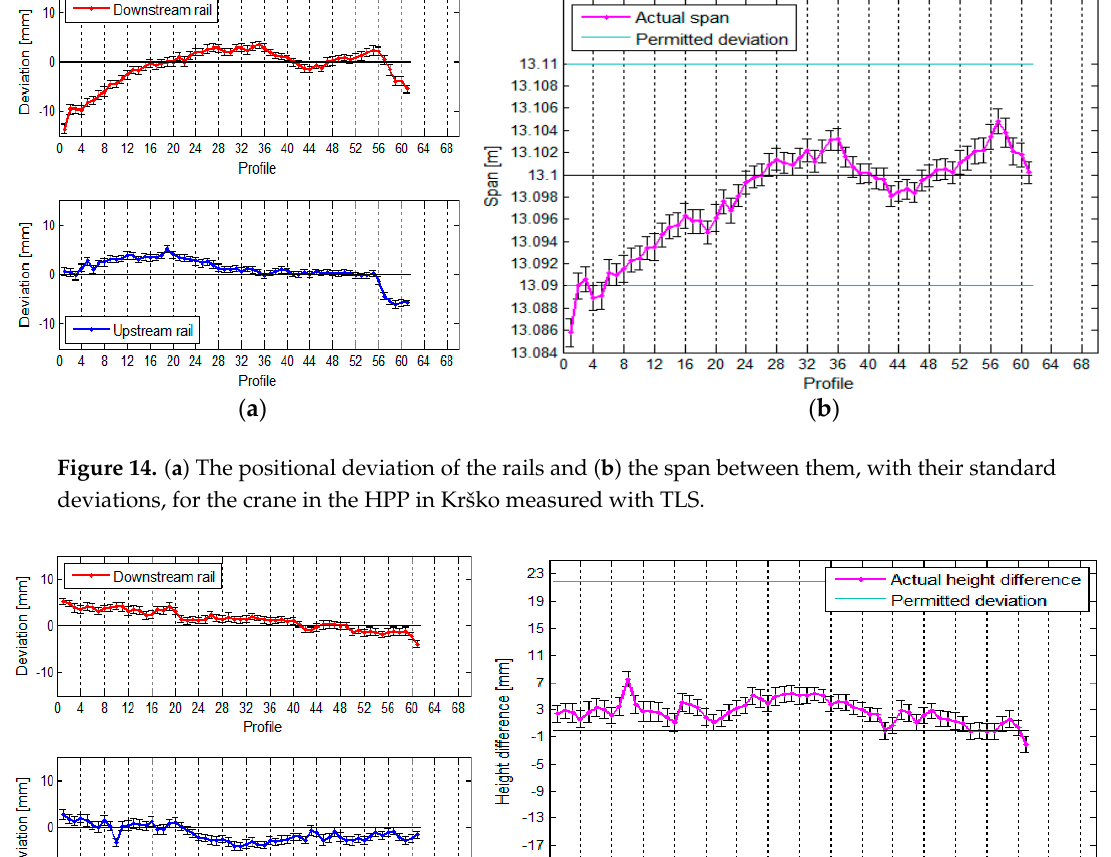
Figure 15. ( a ) The vertical deviations and ( b ) the height differences between the rails, with their standard deviations, for the crane in the HPP in Krško measured with TLS.